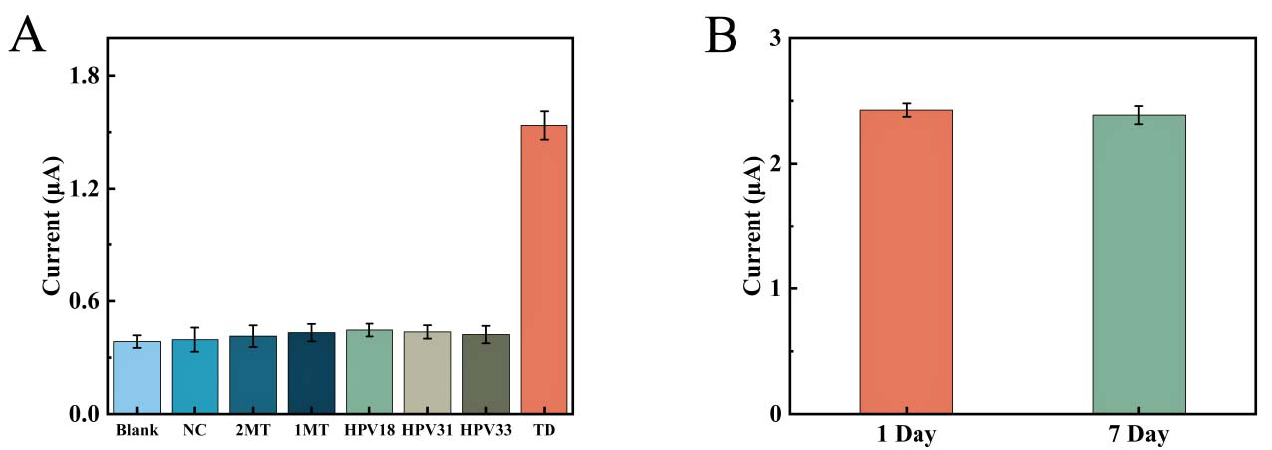
Figure 8. ( A ) Comparison of DPV responses between blank sample sets and different DNA sequences (NC, 2MT, 1MT, HPV18, HPV31, HPV33, TD). ( B ) DPV response before and after the sensor was placed at 4 ◦ C for 7 days. Three sets of parallel experiments were used for error analysis in each